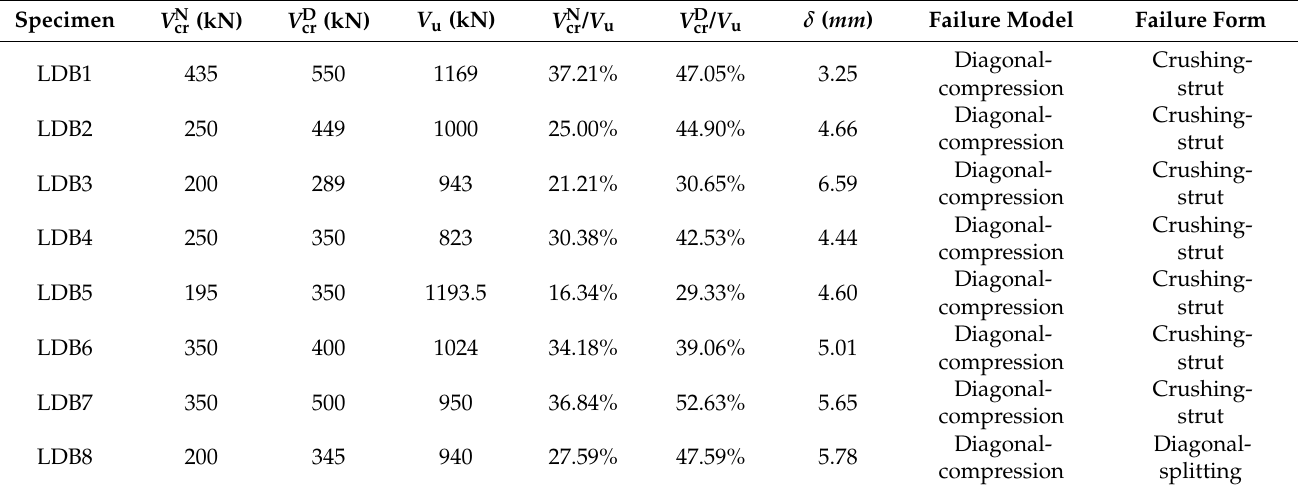
Table 4. Test results of LDB series specimens.